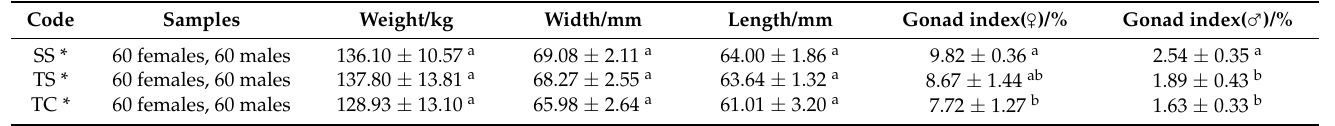
Table 1. The characteristics of E. sinensis